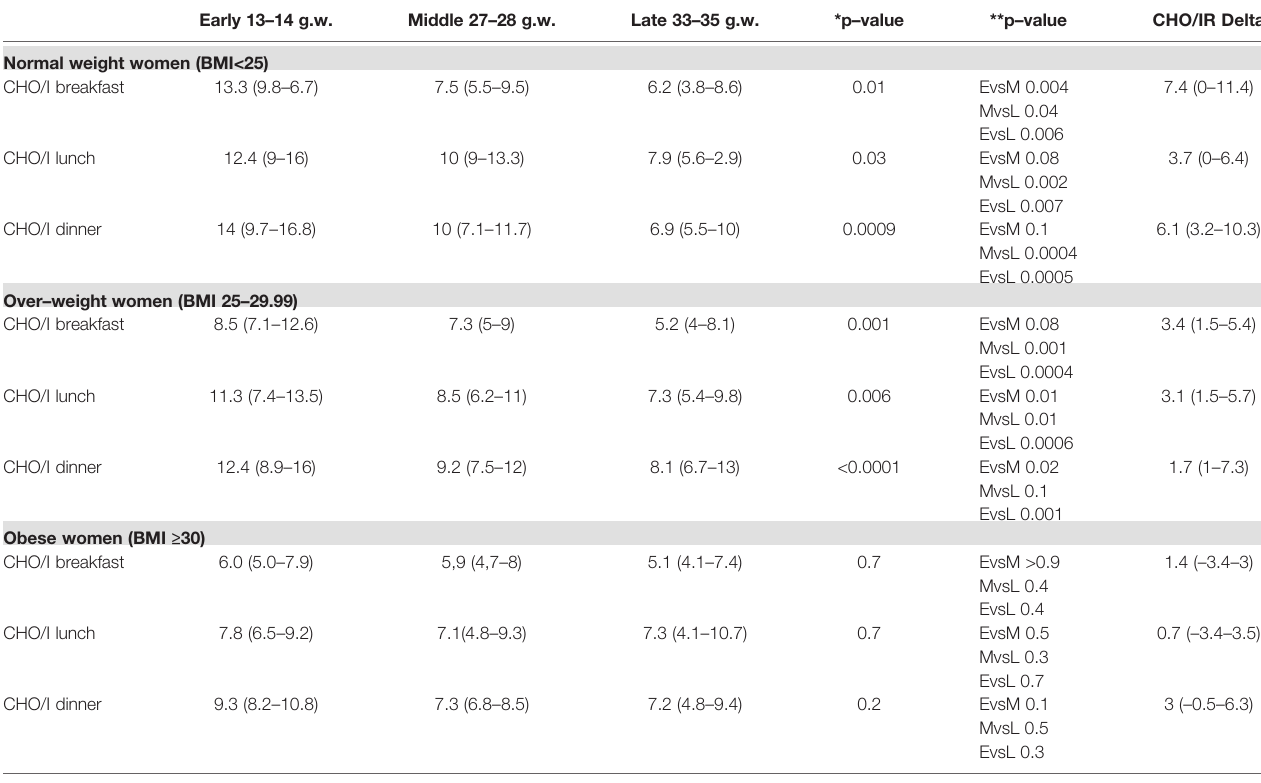
TABLE 4 | CHO/I in normal weight, over – weight and obese women with type 1 diabetes across early, middle, and late